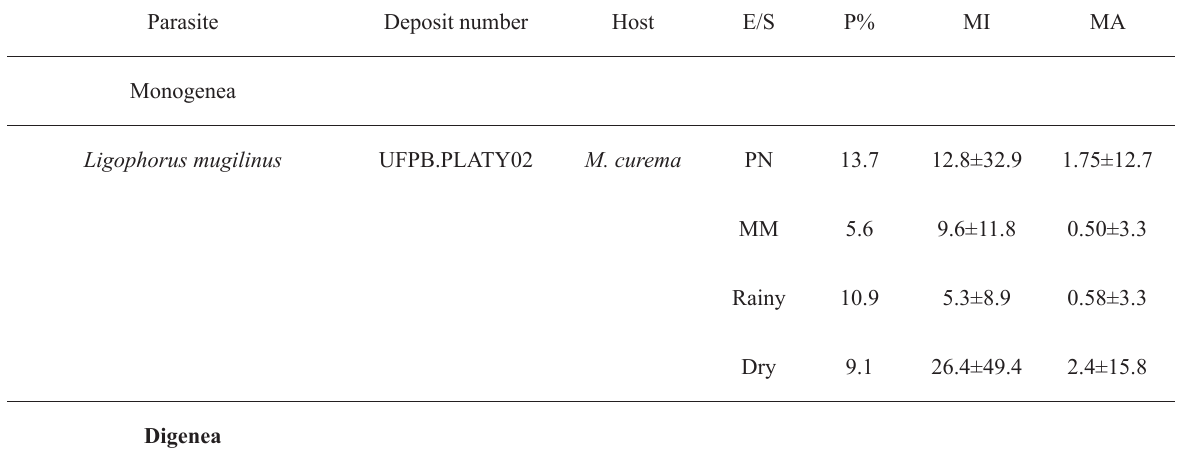
Taxa and catalog numbers of voucher specimens of gill parasites of fish from the estuaries (E) of the rivers Paraíba do Norte (PN) and Mamanguape (MM), in the rainy and dry seasons (S) and respective values of prevalence (P%), mean abundance (MA) and mean intensity (MI) of infection. Letters and symbols indicate new host-parasite record ( nh ),new geographical record ( ng ), and significant differences between estuaries or